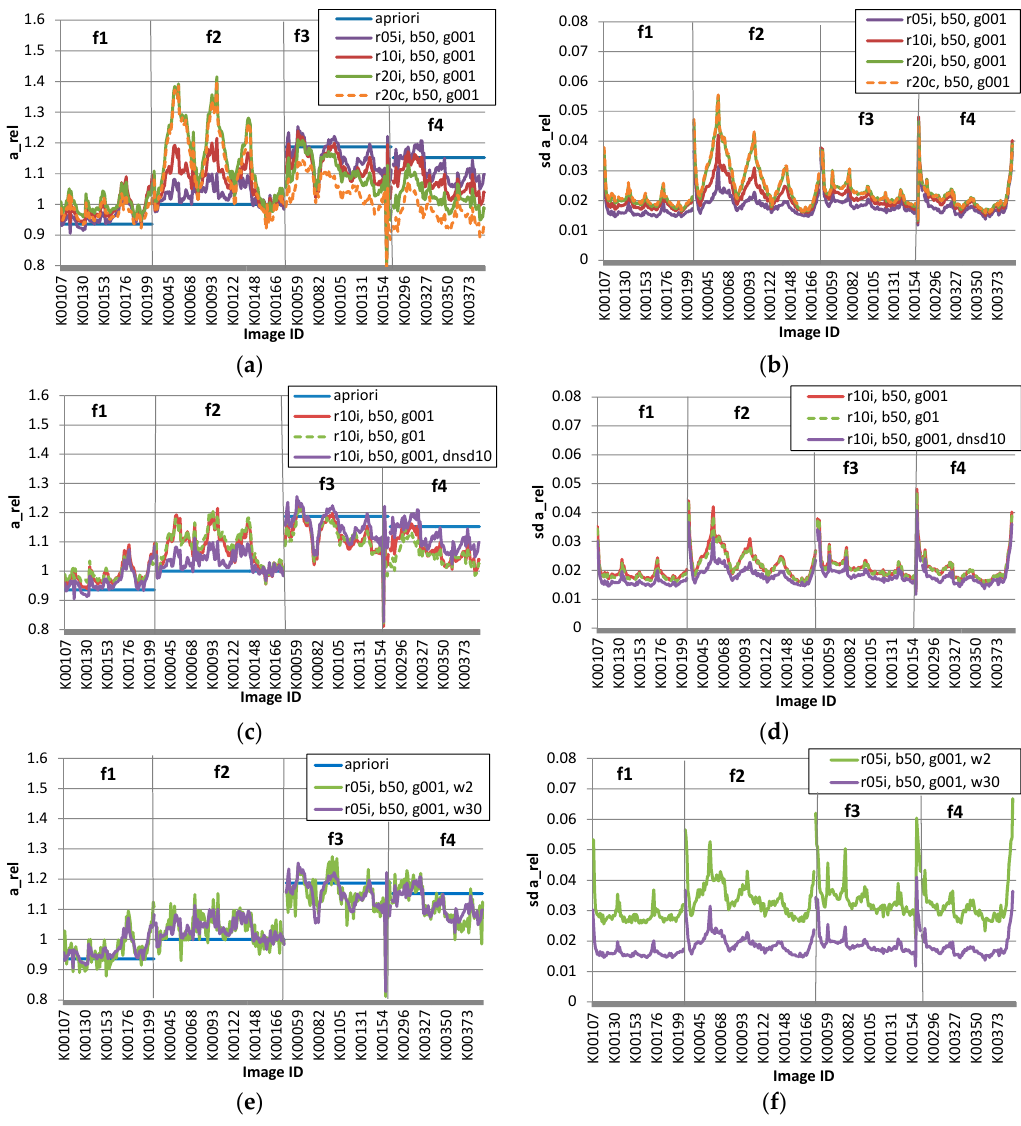
Figure 5. Impact of the adjustment settings on a rel parameters and their standard deviations for all the images. Green band with L0 = 549.6 nm. ( a ) Impacts of varying weighting and the initial values of the a rel on the adjusted values of a rel and ( b ) on their a posteriori standard deviations; ( c ) impacts of varying weighting of RCPs and DNs on the a rel parameters and ( d ) on their a posteriori standard deviations; ( e ) impact of the varying size of the tie points’ image window size on the adjusted values of a rel and ( f ) on their a posteriori standard deviations. Weighting and a priori value settings: r05i, r10i, r20i: σ a _ rel = 0.05, 0.1 and 0.2, respectively, a priori values: Intersil irradiance; r10c, r20c: σ a _ rel : 0.1 and 0.2, respectively, a priori values: 1.0; b100, b50, b20: σ BRDF 100%, 50% and 20% of a priori values; g001, g01: σ RCP = 0.001 and 0.01, respectively; dn10: σ DN = 0.10, in other cases σ DN = 0.05; w2, w10, w30: tie point window size 2 × 2, 10 × 10 and 30 × 30 pixels, respectively (if not marked, 30 × 30 pixels).